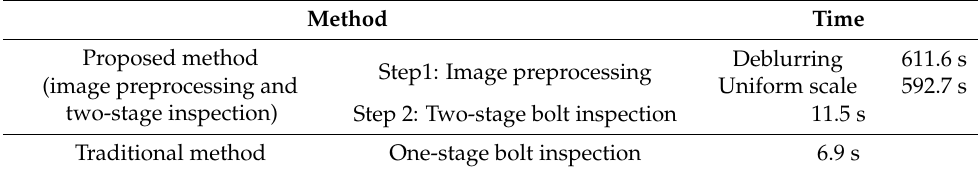
Table 2. Bolt image processing time of the three methods.